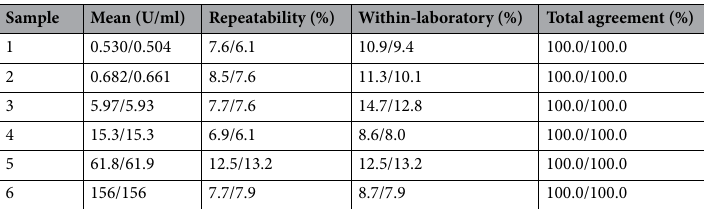
Table 2. Imprecision of extracted DBS samples (reagent lots